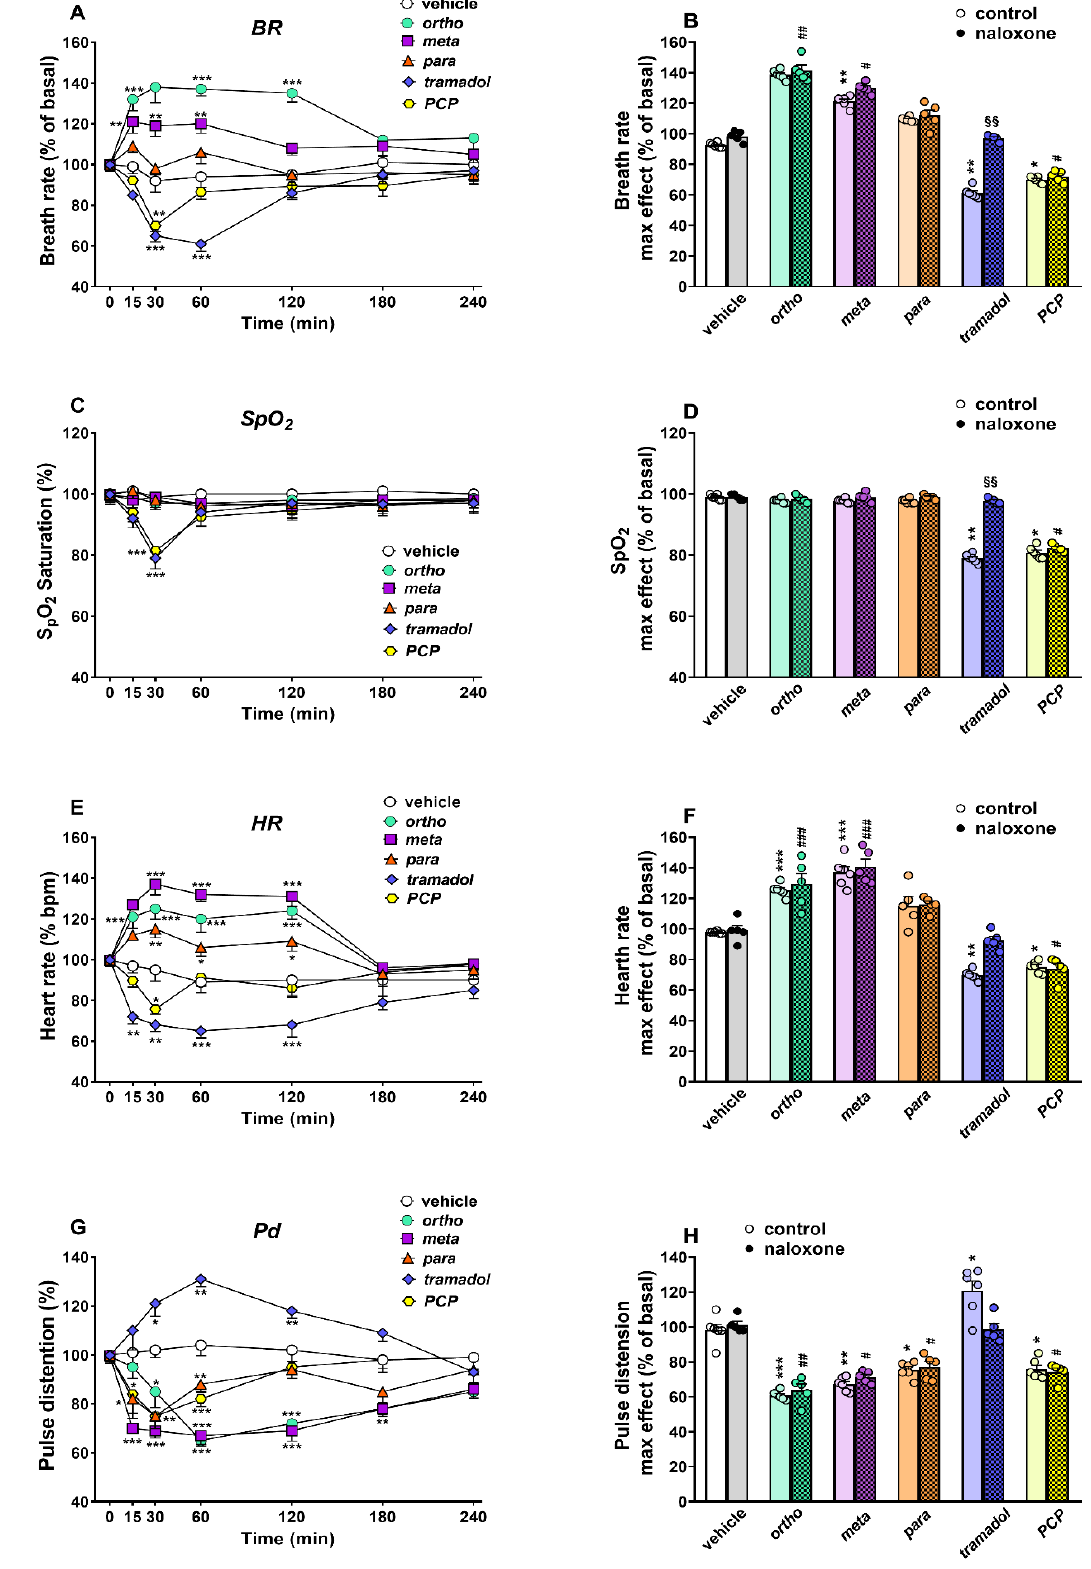
Figure 11. Effect of the systemic administration of ortho, meta, para, tramadol (100 mg/kg i.p.) and PCP (10 mg/kg i.p.) on breath rate (BR; ( A )), on arterial saturation (SpO2; ( C )), heart rate (HR; ( E )) and pulse distention (Pd; ( G )). Interaction of the effective doses of ortho, meta, para, tramadol (100 mg/kg) and PCP (10 mg/kg) with the opioid receptor antagonist naloxone (6 mg/kg, i.p.) on breath rate (BR; ( B )), arterial saturation (SpO2; ( D )), heart rate (HR ( F )) and pulse distention (Pd; ( H )).